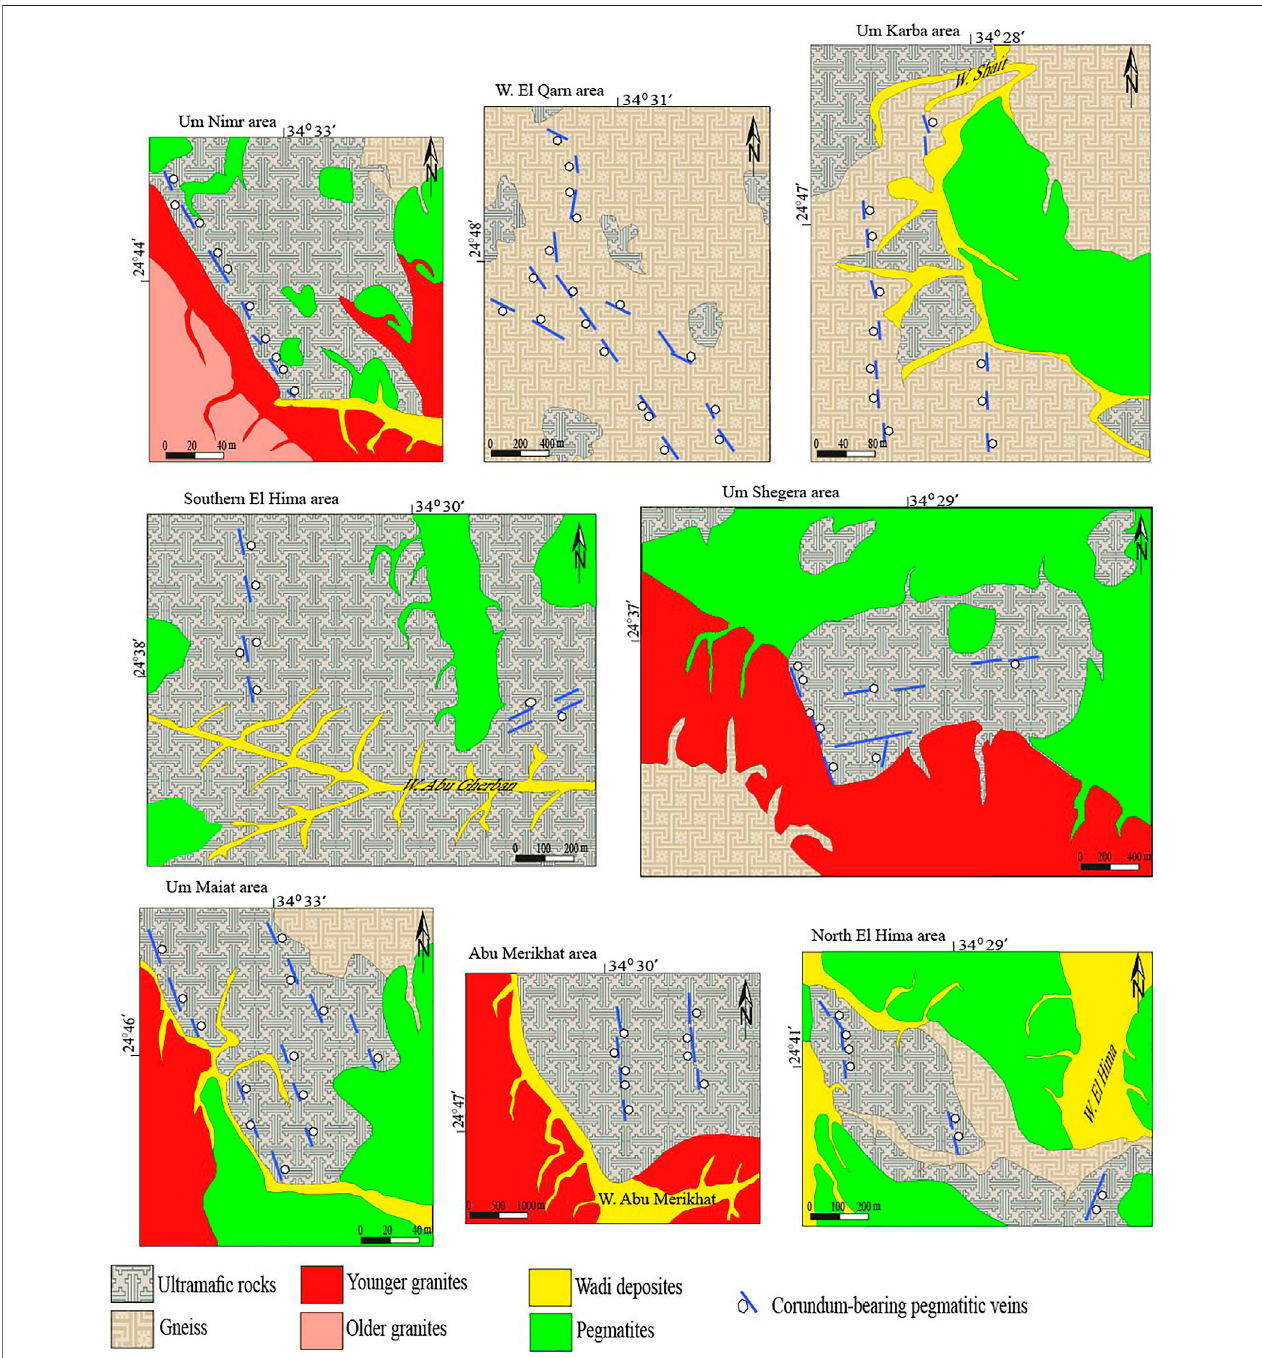
FIGURE 2 | Field-scale geologic maps of the eight studied areas showing the distribution of the corundum-bearing pegmatites in the host rocks (ultrama fi cs and gneisses). For locations, Figure 1 .